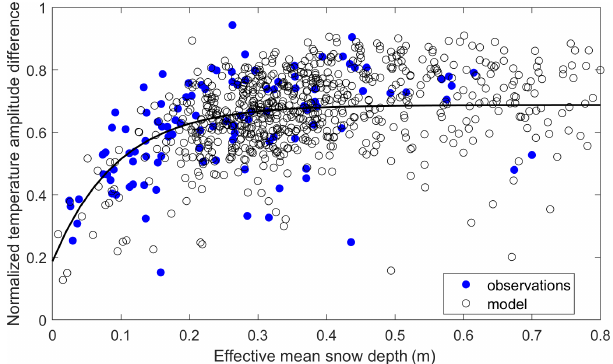
Figure 3. Comparison of the snow insulation curve derived from in situ measurements and model simulations at the Alaskan SNO- TEL sites. The dark line is drawn using the following parame- ters presented in Slate et al. (2017): A norm = 0 . 1875 + 0 . 5 × ( 1 − e − (S depth , eff / 0 . 0941 ) ) . Observations have fewer data points due to data gaps in the observed snow depth and soil temperatures at the SNOTEL